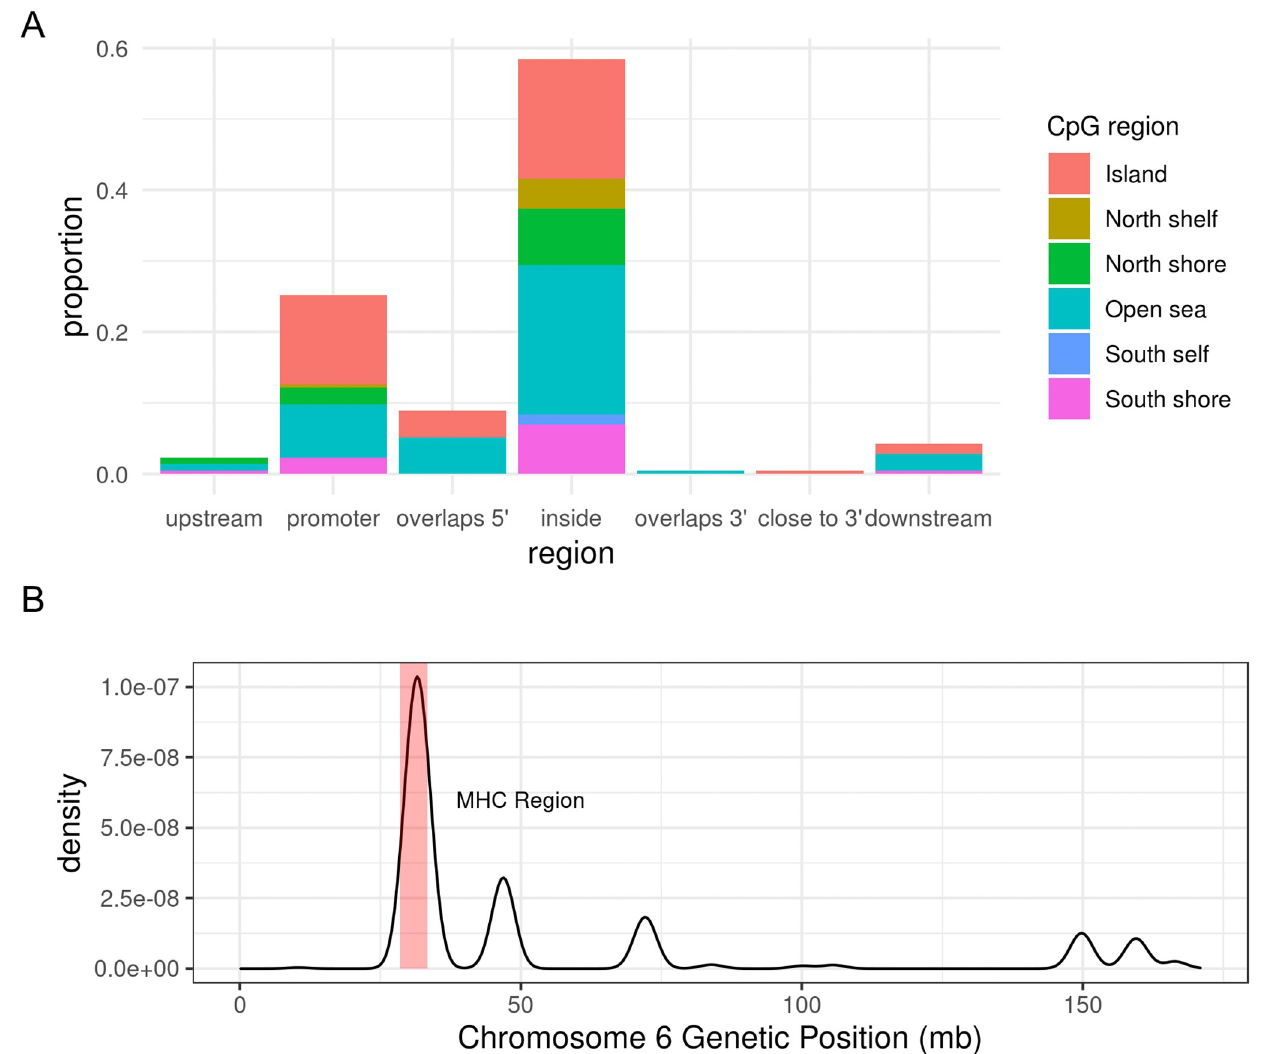
Fig 1. DMR characteristics. (A) Proportion of SS DMR locations relative to closest gene, and CpG type proportions at each DMR location; most DMRs are located either in the gene body (inside) or promoter, and most DMR CpG sites are either in the CpG island or the open sea. (B) Density plot of SS DMR locations on chromosome 6, where a DMR’s location is represented by GRCh37 genetic coordinates of its first CpG site to last CpG site. The shaded red region denotes the MHC region (28,477,797 bp—33,448,354 bp on chromosome 6). mb = megabase pairs.